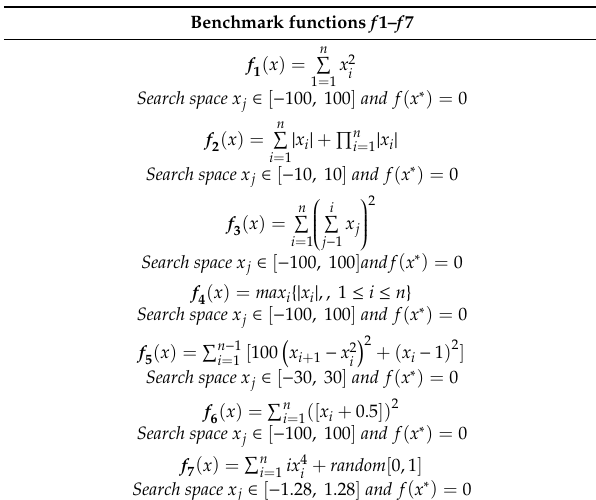
Table 2. Unimodal benchmark